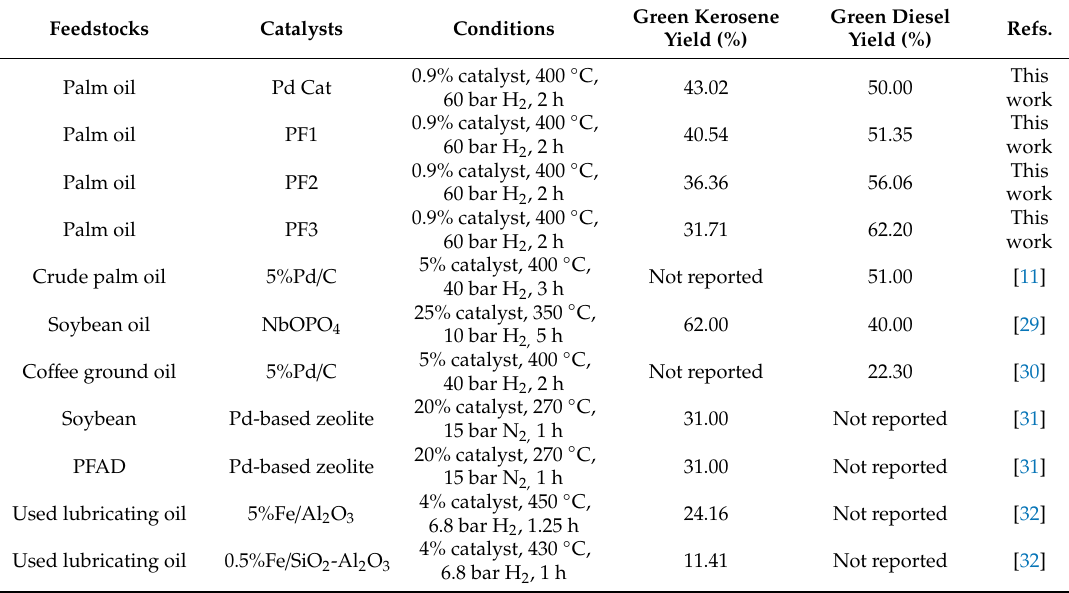
Table 4. Comparative green kerosene and green diesel yields via catalytic cracking reactions with di ff erent catalysts and operating